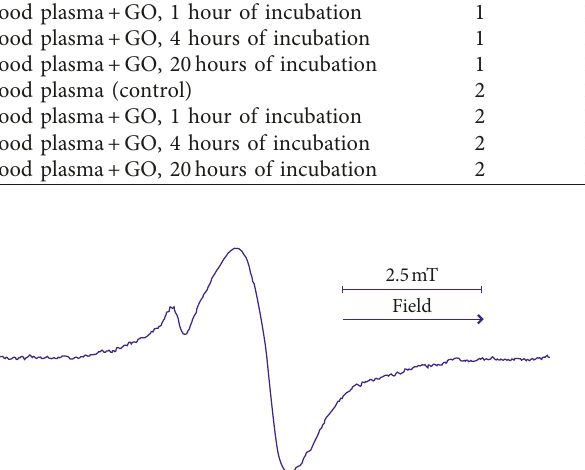
Figure 7: ESR spectrum of spin probe 1 in the erythrocyte sus- pension in the presence of GO suspension (70 μ g/ml).